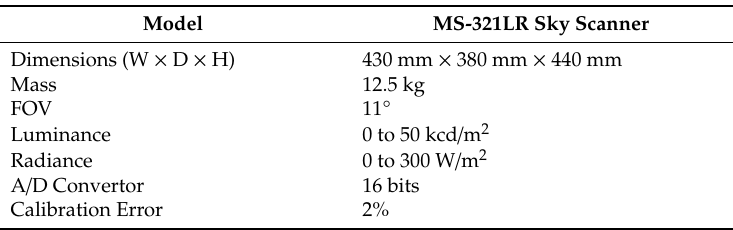
Table 1. Sky scanner specifications.